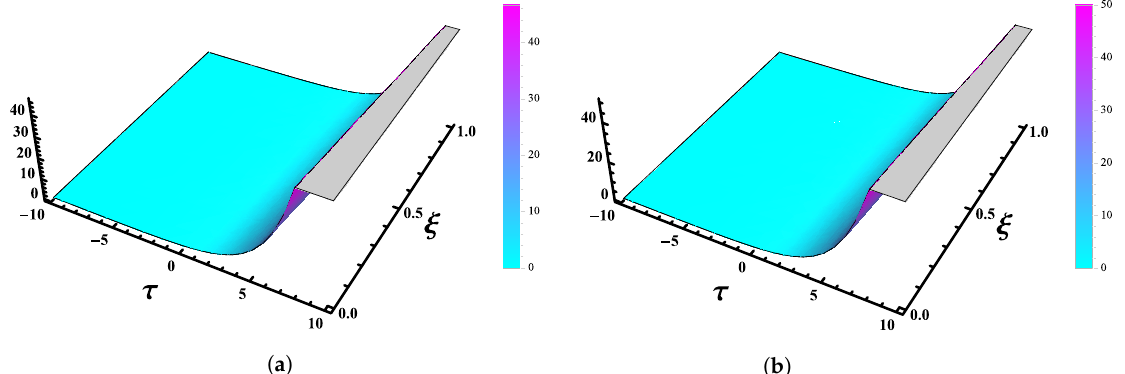
Figure 10. Three-dimensional plots of ( a ) the exact and ( b ) FNAM solutions at τ ∈ [ − 10,10 ] and ξ ∈ [ 0,1 ] for Example 2.